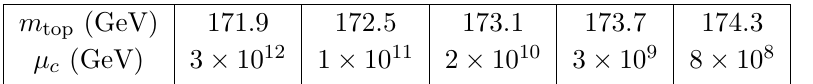
Table 1 . The value of (cid:22) c for several top quark masses. Here we take the Higgs mass to be 125.1 GeV and (cid:11) 3 ( m Z ) = 0 :